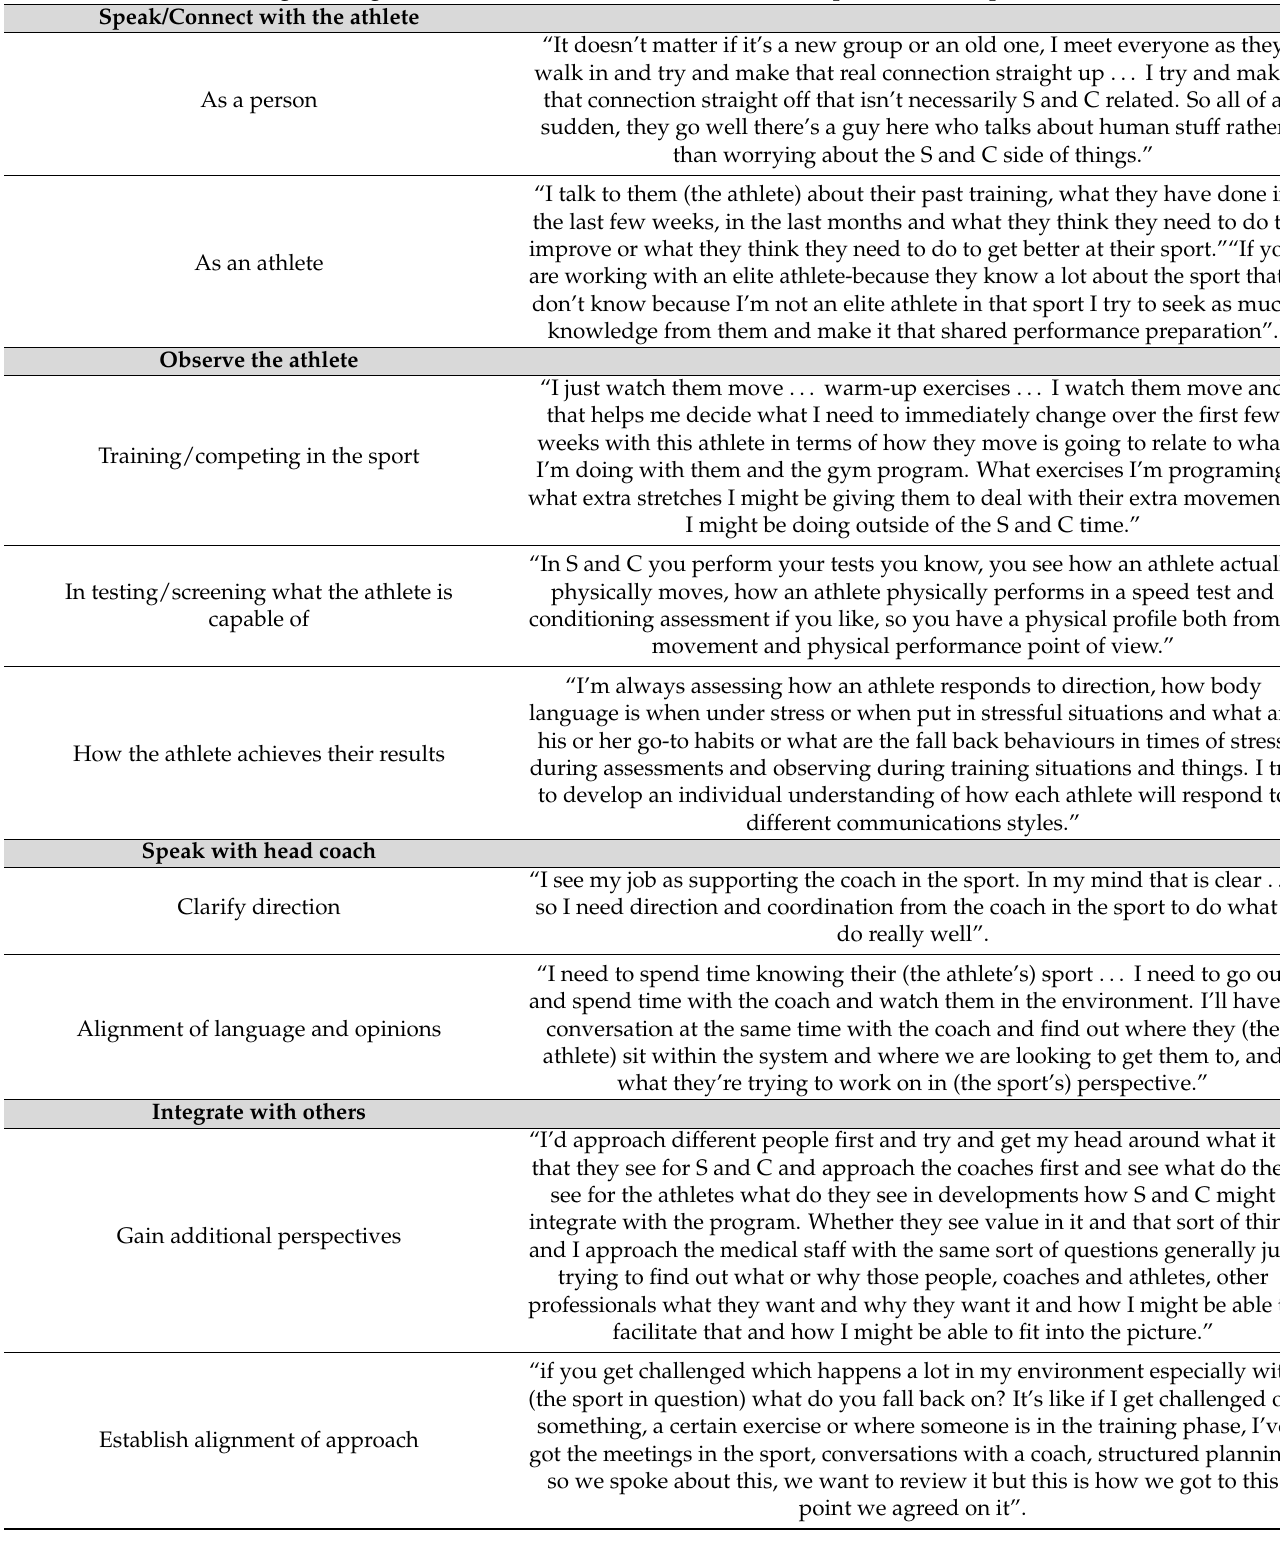
Table 3. Summary of themes within task diagram responses for training program design considerations. Themes within Task Diagram Stage of